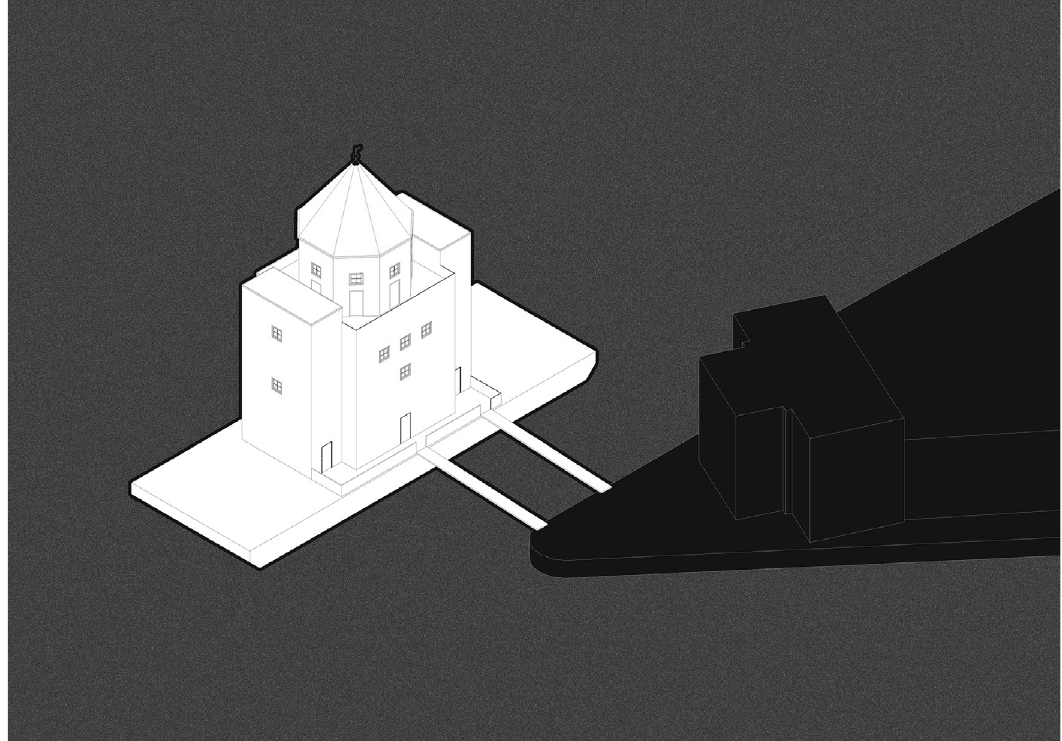
Figure 8. Extension of Venetian public space due to Aldo Rossi’s “Theatre of the World” at Punta della Dogana in